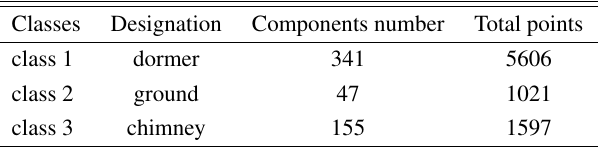
Table 1. Detail of each class from selected samples regions